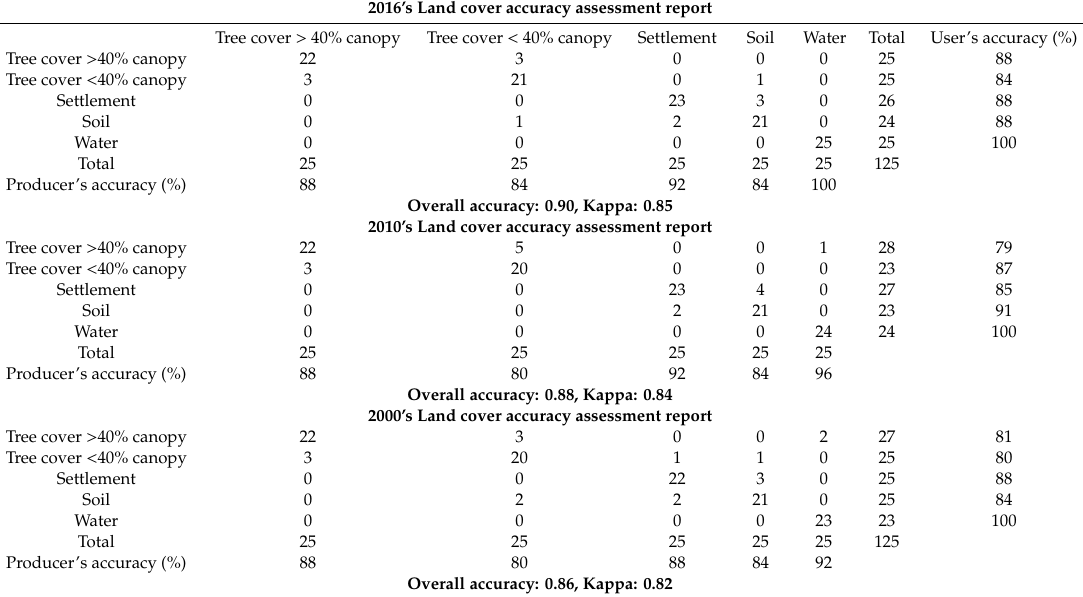
Table A1. Accuracy assessment of land covers classification for 1976, 1990, 2000, 2010, and